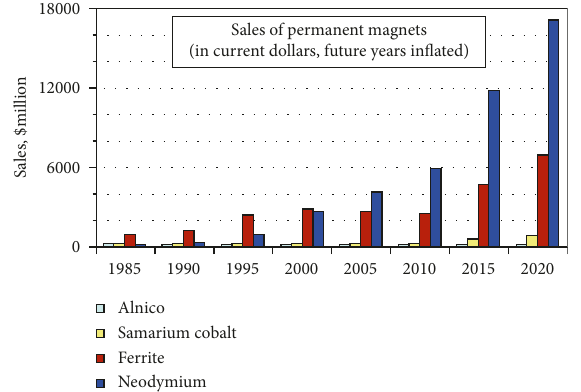
Figure 2: Projected growth in demand for permanent magnets from 1985 to 2020